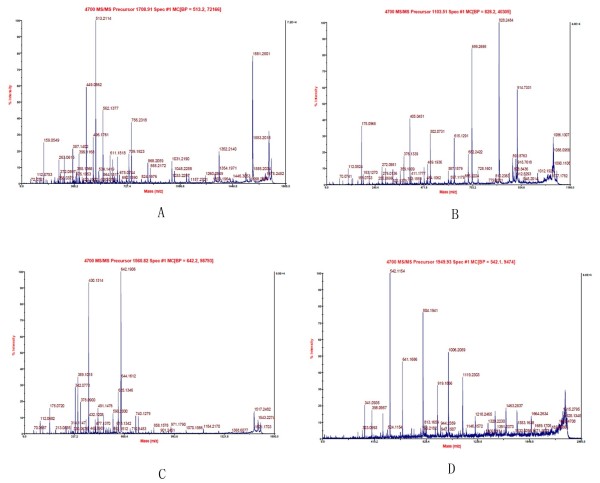
Identification of proteins by MS and MS/MS. As an example, the identification of phosphatidylethanolamine-binding protein 1 is represented here. The protein from spot 1010 was excised from the gels and digested with trypsin, and the resulting peptides were analysed using a MALDI-TOF/TOF mass spectrometer. (A) The MS spectrum and (B) the MS/MS spectrum for the peptide CDEPILSNR. (C) The MS/MS spectrum for the peptide LYTLVLTDPDAPSR. (D) The MS/MS spectrum for the peptide GNDISSGTVLSDYVGSGPPK. The chart represents m/z (horizontal) versus intensity (vertical). The spectra for the tryptic peptides of PEBP 1 were annotated using the GPS explorer software, v3.6 and the Mascot search engine, v2.1 with the UniprotKB/SwissProt database.